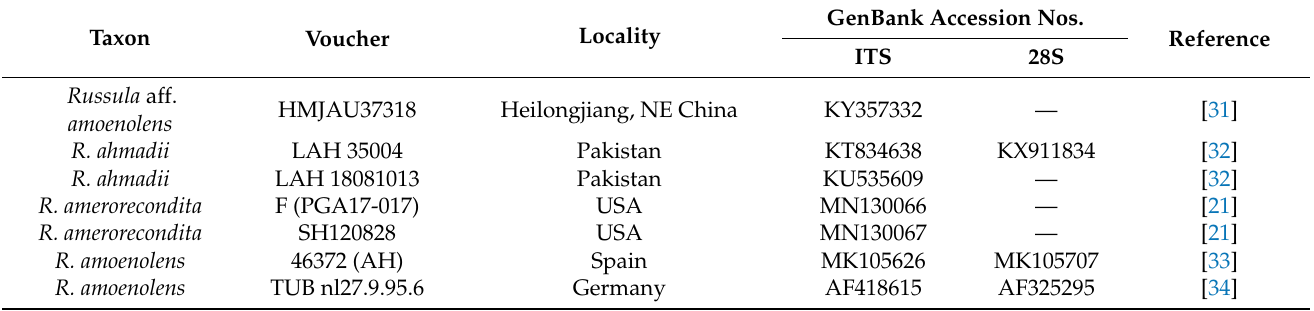
Table 1. Taxa, vouchers, locations, and GenBank accession numbers of DNA sequences used in this study. The new sequences are in